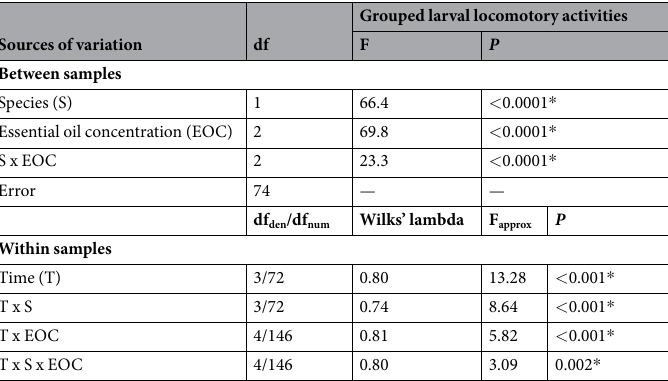
Table 4. Results of the multivariate analysis of variance for the walking behavior of the 3 rd instar larvae of key lepidopteran pests (i.e., S . frugiperda and A . gemmatalis ) in arenas treated with either the LC 10 or LC 50 of the oil of S . guianensis . T : time of exposure (i.e., 3, 6 and 16 h); S : insect species (i.e., S . frugiperda and A . gemmatalis ); EOC : LC 10 and LC 50 values of the S . guianensis essential oil estimated for each lepidopteran